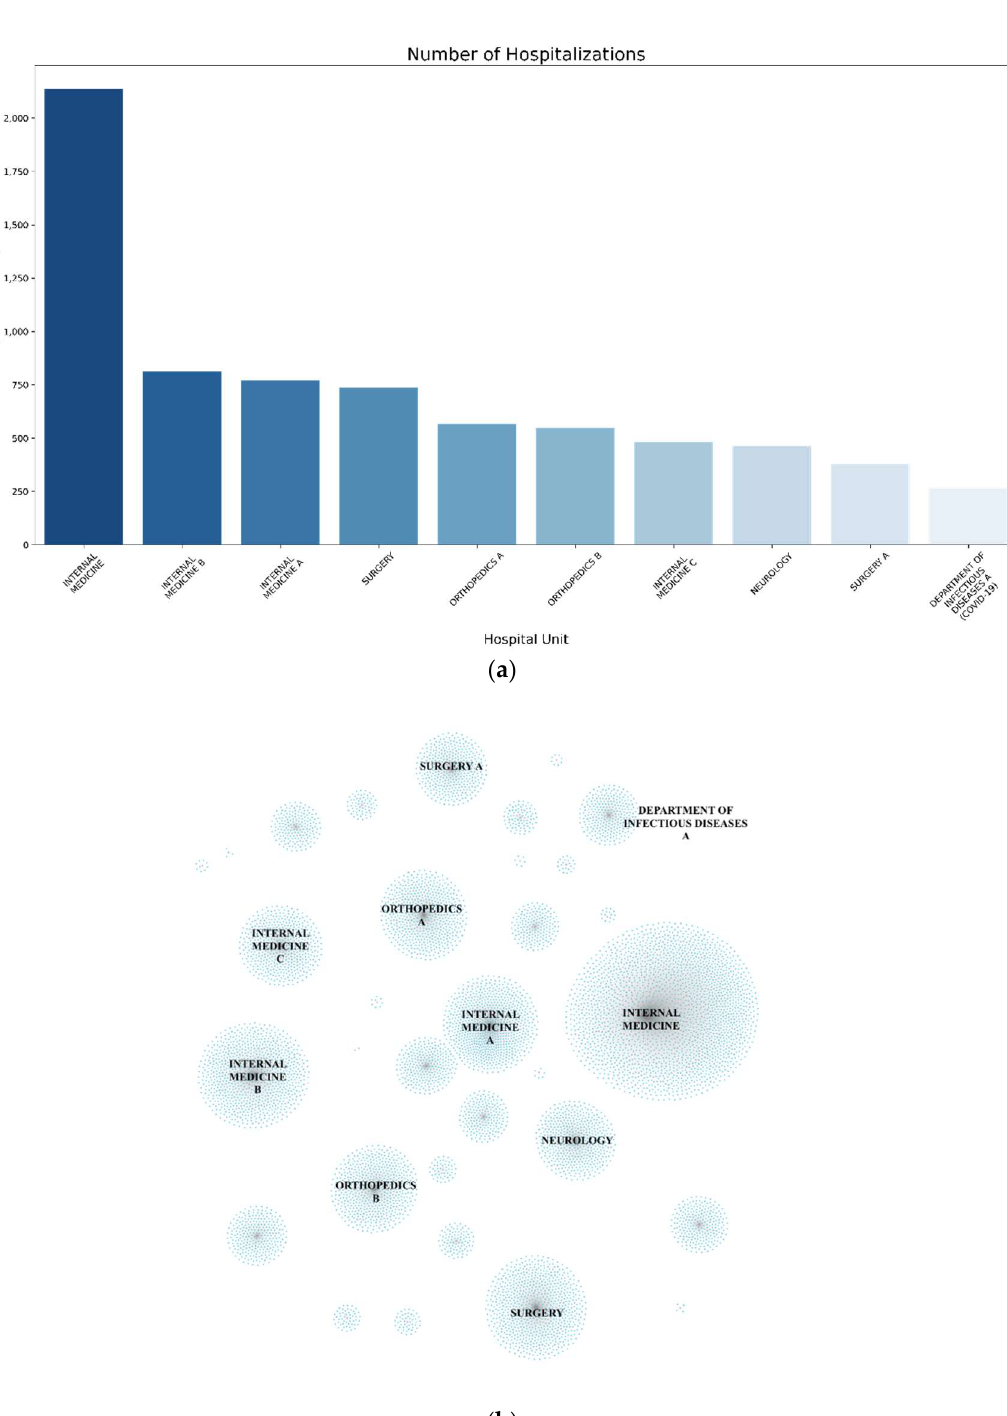
Figure 4. ( a ) Bar chart of Top 10 hospital units with highest hospitalizations. ( b ) Neo4j bloom graph visualization showing the same.